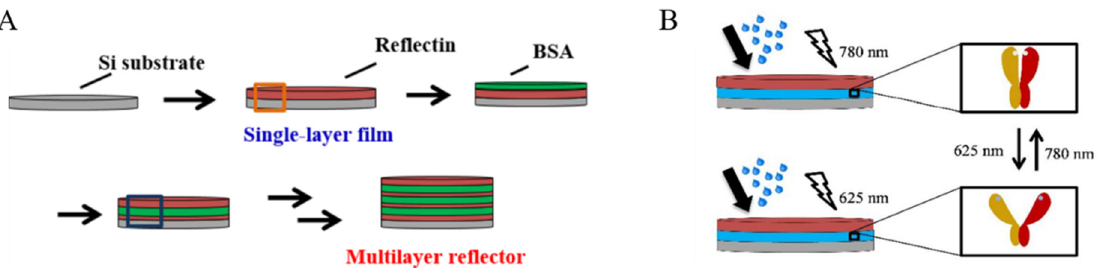
Figure 6. ( A ) Structure of the reflectin/BSA composite sheet layer inspired by cephalopods; ( B ) Light response of the phytochrome/reflectin composite sheet layer [40]. Copyright 2021, Nature Publish- ing Group.